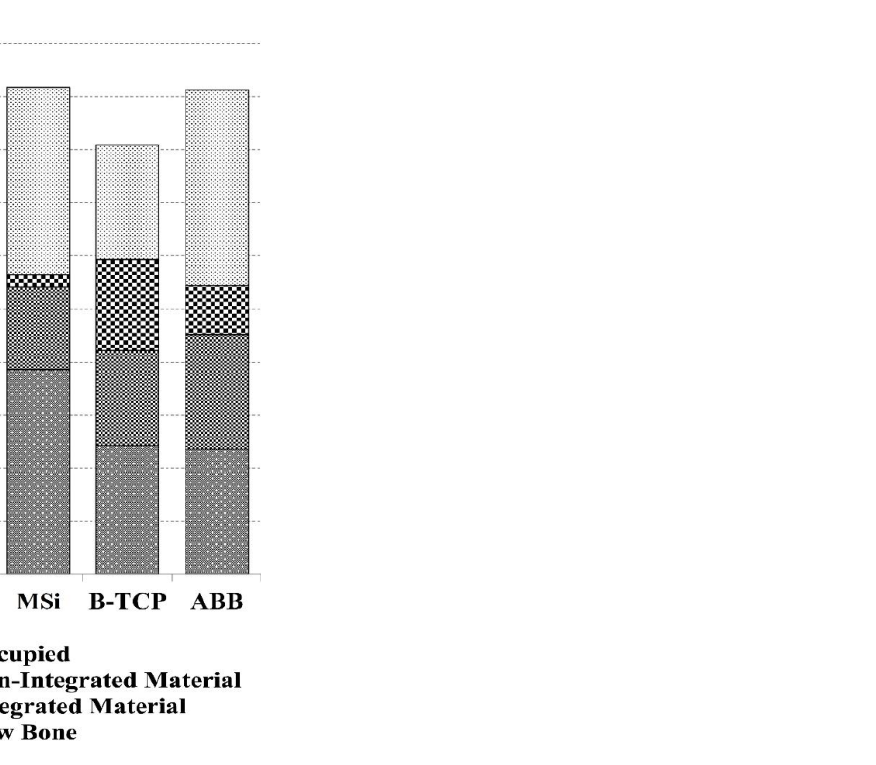
Figure 5. Graphical representation of the histomorphometric determinations for: ABB, β -TCP and MSi.